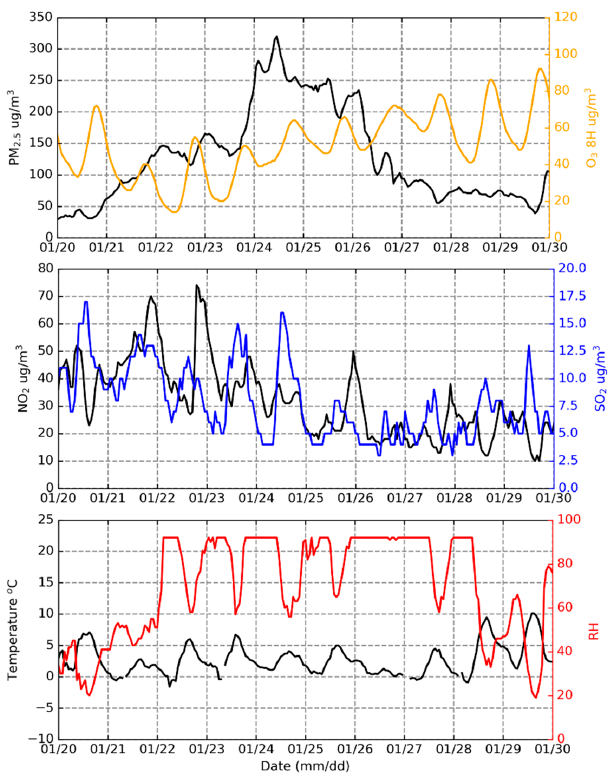
Figure 11. Temporal variation of near-surface PM 2.5 , O3 8H (8 h moving average O3